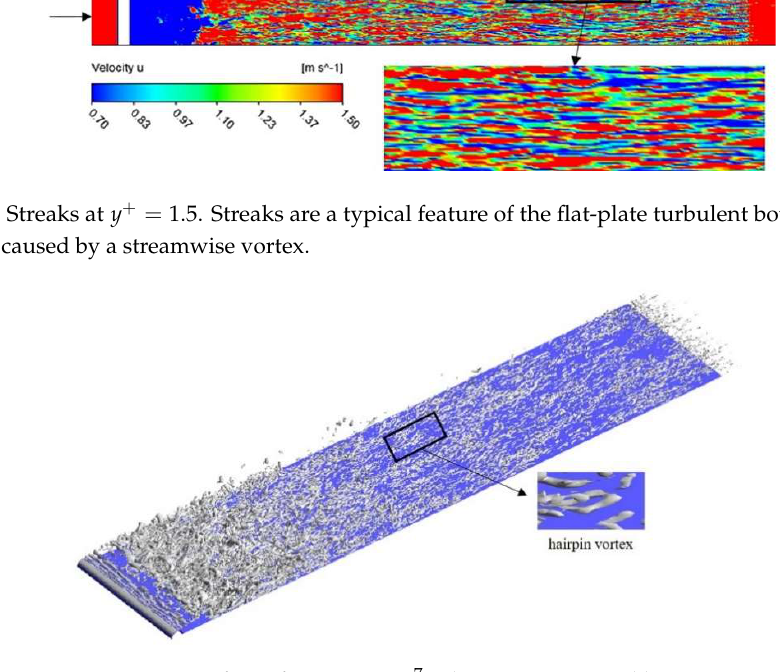
Figure 7. Instantaneous iso-surface of Q = 4.3 × 10 7 . The streamwise and hairpin vortices are typical Figure 7. Instantaneous iso-surface of 𝑄 = 4.3 × 10 (cid:2875) . The streamwise and hairpin vortices are typical features of the flat-plate turbulent boundary Figure 7. Instantaneous iso-surface of 𝑄 = 4.3 × 10 (cid:2875) . The streamwise and hairpin vortices are typical features of the flat-plate turbulent boundary layer. Figure 7. Instantaneous iso-surface of 𝑄 = 4.3 × 10 (cid:2875) . The streamwise and hairpin vortices are typical features of the flat-plate turbulent boundary layer. features of the flat-plate turbulent boundary layer.